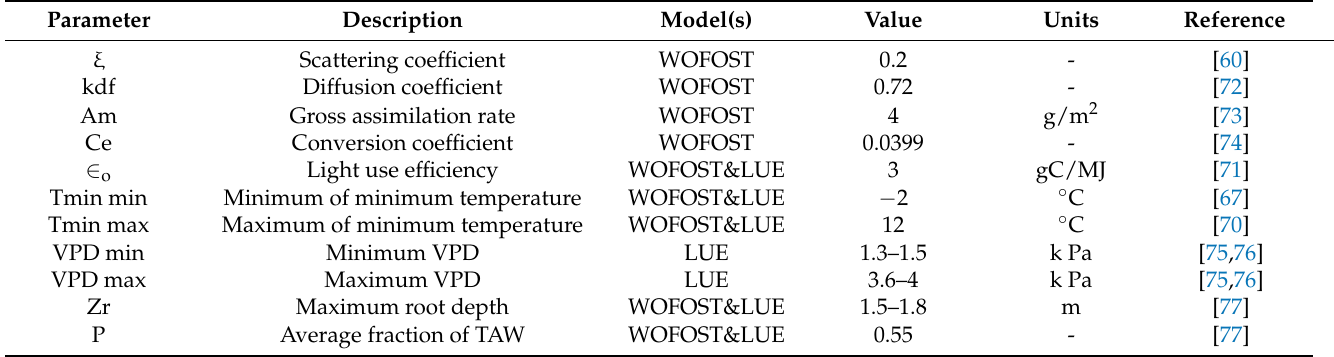
Table 4. Description of model calibration values taken from the related literature for the WOFOST and LUE models, plus, the climate thresholds used to calculate the climate stress indexes used in the design of a